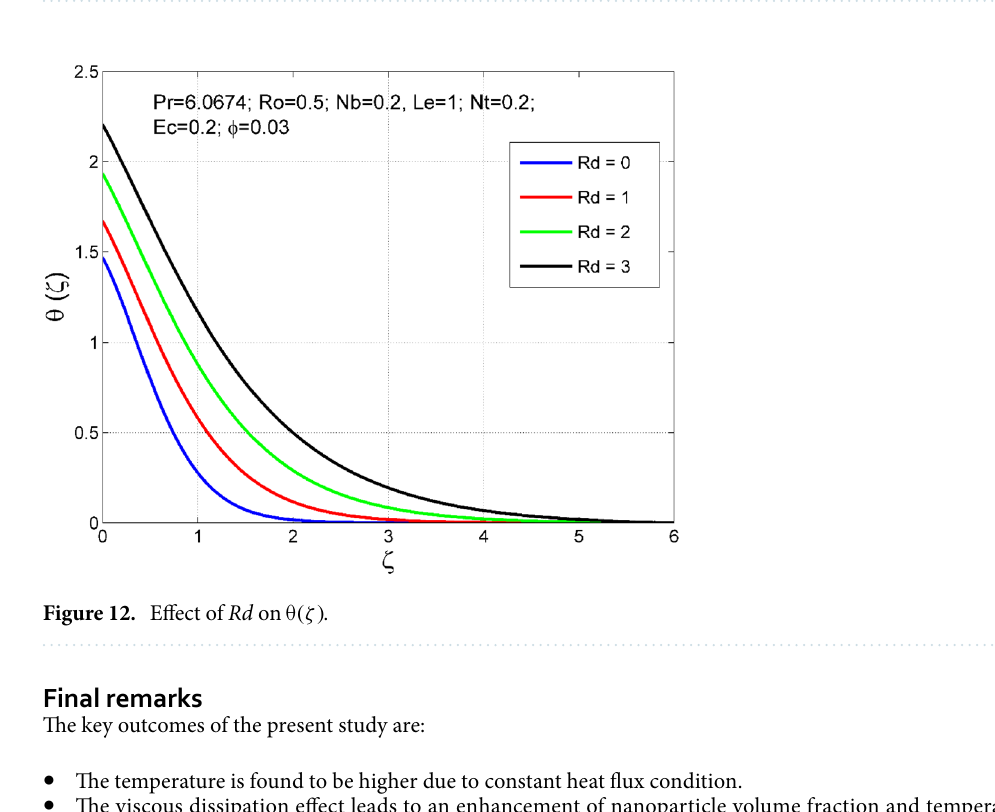
Figure 11. Effect of Ec on �(ζ) .